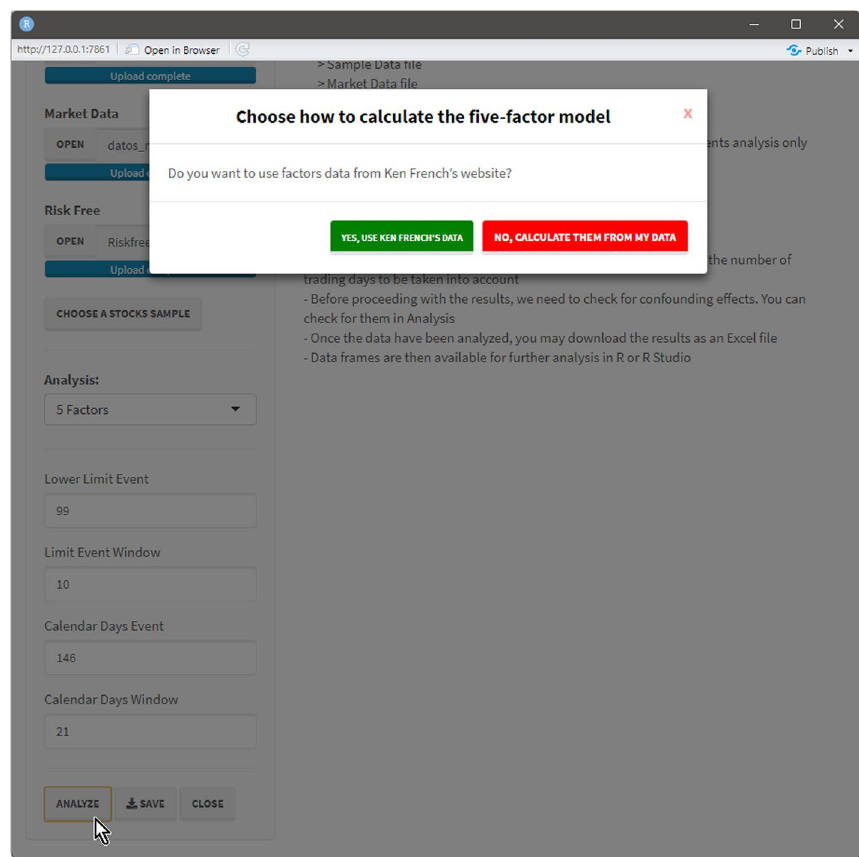
Fig. 16 Market portfolio data source pop‑up. Source : Created by authors